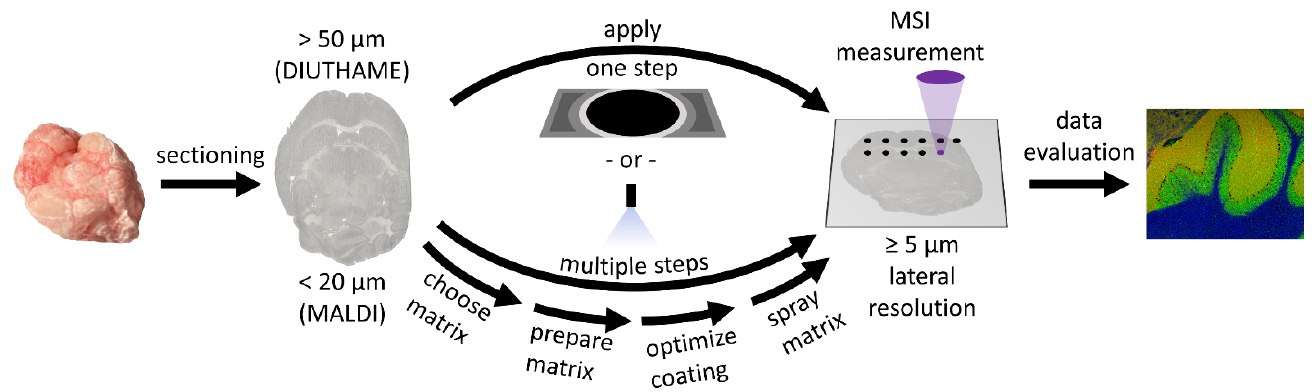
Figure 6. Illustrative overview of the workflow for a DIUTHAME and a MALDI MSI measurement, respectively. The main difference in the workflow is the preparation step between sectioning and MSI measurement.